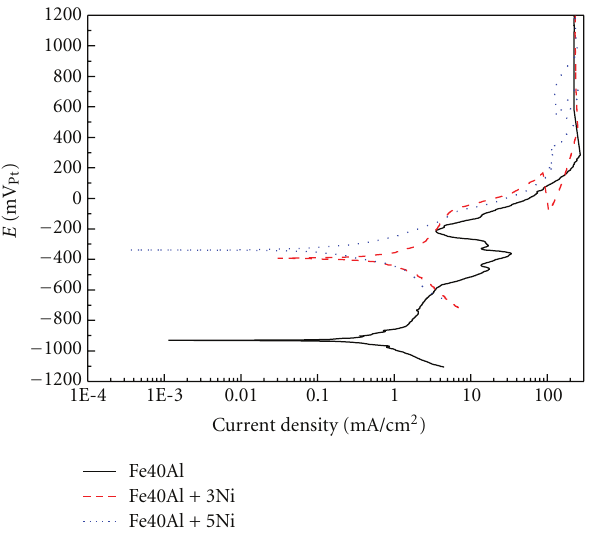
Figure 4: E ff ect of Ni on the polarization curve for Fe40Al alloy in NaCl-KCl (1:1 molar ratio) salt in static air at 670 ◦ C.